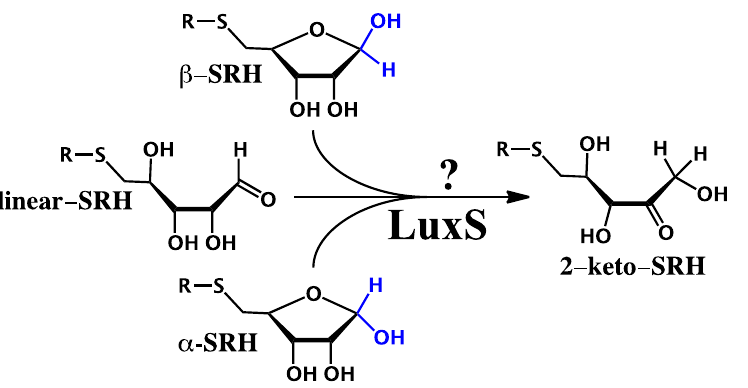
Scheme 6. Schematic representation of the conjectured conversion of S -ribosylhomocysteine ( α -SRH), β -SRH and linear-SRH into common putative 2-keto mechanistic